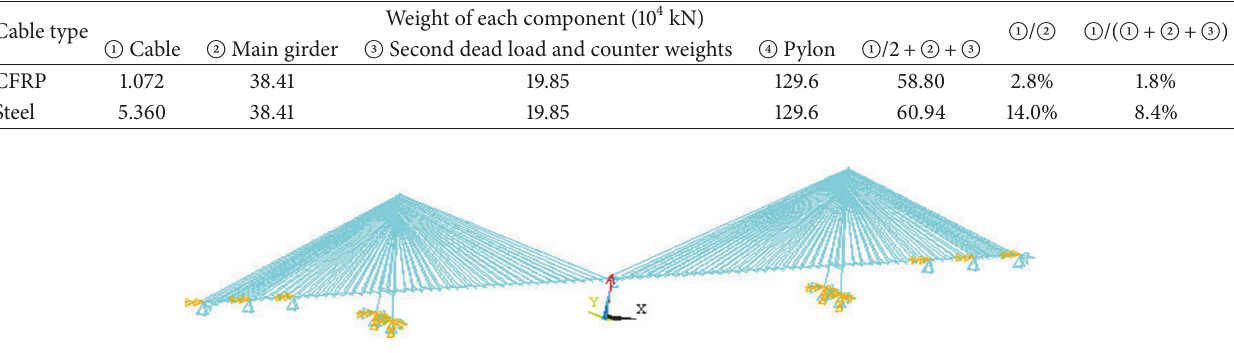
Figure 6: Model for